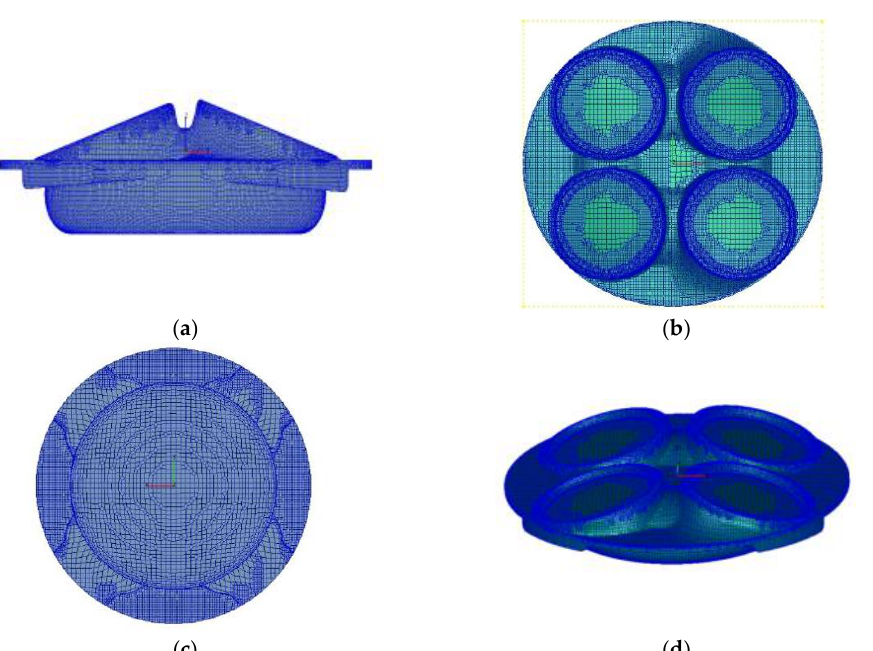
Figure 3. Computation mesh of the tumble combustion system. ( a ) Front view; ( b ) Vertical view; ( c ) Bottom view; ( d ) 3D simulation model mesh.